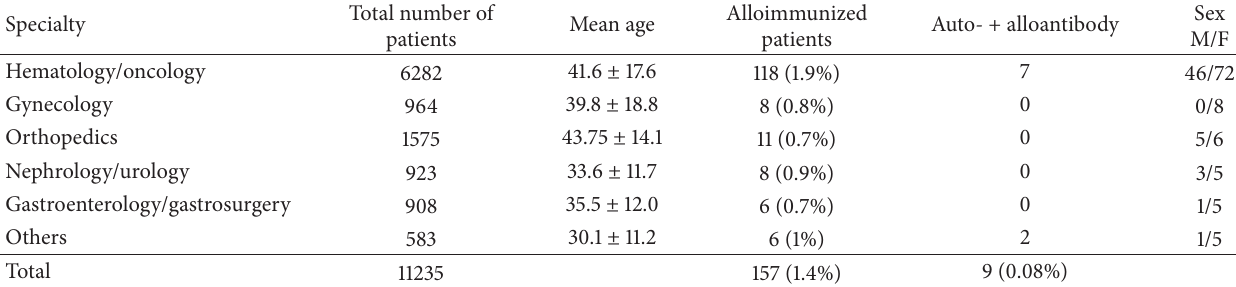
Table 2: Distribution of patients according to clinical specialties.